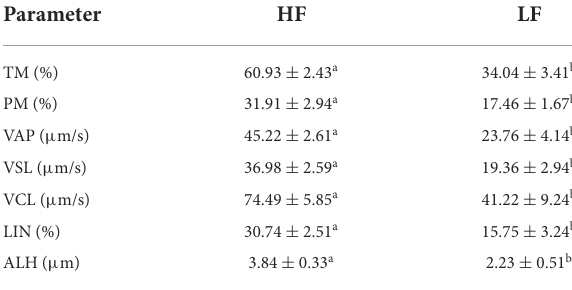
TABLE 2 Differences in the motion kinematics between HF and LF.